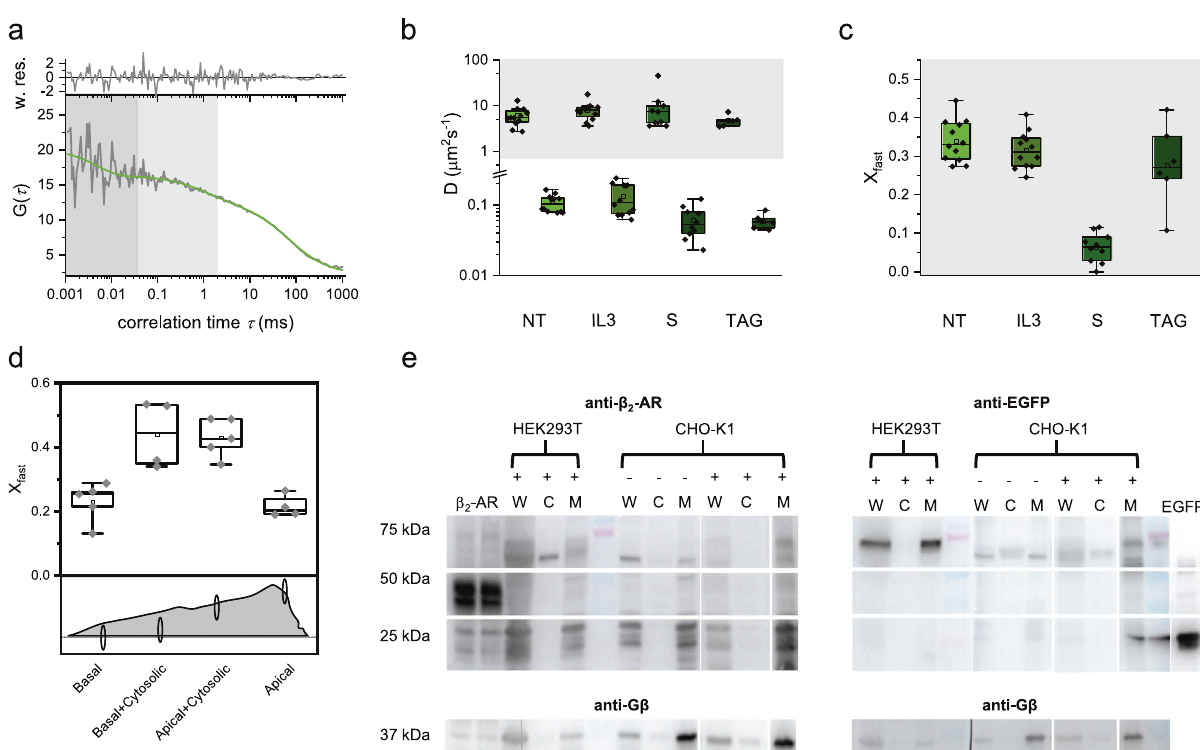
Fig. 2 FCS data reveal β 2 -AR diffusion on two different time scales. a FCS curve derived from the basal membrane of a CHO-K1 cell transiently transfected with N-terminal-EGFP- β 2 -AR (NT). The curve was fi tted with the model 2D3DT (Eq. (4)) containing two diffusion times ( t D1 = 68.7 ± 1.13 ms, white and t D2 = 0.75 ± 0.10 ms, light gray) and a relaxation time ( t T = 5.00 ± 5.68 µ s, gray). The weighted residuals are shown on top. Fit results are mean ± s.e.m. b Diffusion constants, D fast (light gray area) and D slow , calculated from the corresponding diffusion times t D1 and t D2 , respectively (Eq. (5)) of NT (light green, 6.08 ± 2.80 and 0.10 ± 0.02 µ m 2 s − 1 for n = 12), IL3 (green, 8.09 ± 3.65 and 0.13 ± 0.06 µ m 2 s − 1 for n = 12), S (meadow green, 11.0 ± 13.2 and 0.06 ± 0.03 µ m 2 s − 1 for n = 10) and TAG (dark green, 4.74 ± 1.36 and 0.06 ± 0.01 µ m 2 s − 1 for n = 6). c Fraction of molecules exhibiting fast diffusion for the same constructs as in ( b ). NT = 0.33 ± 0.05; IL3 = 0.31 ± 0.04; S = 0.07 ± 0.03 and TAG = 0.27 ± 0.10. Results for α 2A -AR are shown in Supplementary Fig. 5. Data are mean ± s.d. d Fraction of molecules exhibiting fast diffusion for NT at different positions on and partly on the plasma membrane. The lower cartoon represents the respective focal positions. The focal volume and the dimension of the cell are drawn to scale. The dimensions of the focal volume were 2.72 µ m × 0.46 µ m and the dimensions of the representative cell were 9 µ m × 40 µ m. Basal 0.22 ± 0.06; Basal + Cytosolic 0.44 ± 0.10; Apical + Cytosolic 0.42 ± 0.06; Apical 0.21 ± 0.03. Data are mean ± s.d. Diffusion constants for all the cell are shown in Supplementary Fig. 9. e Western Blot of untransfected ( − ) CHO-K1 and NT transfected ( + ) HEK293T and CHO-K1 cells. For both samples, the whole cell lysate (W), the separated cytosol (C) and membrane (M) fractions were loaded (see the section “ Methods ” for details). As a positive control for NT, HEK293T transfected with untagged β 2 -AR ( “ β 2 -AR ” ), and for EGFP, puri fi ed EGFP ( “ EGFP ” ) were used. As loading control the same gels were probed for G β after stripping. The full blots along with the controls can be seen in Supplementary Fig. 10. Blots for S construct can be seen in Supplementary Fig.